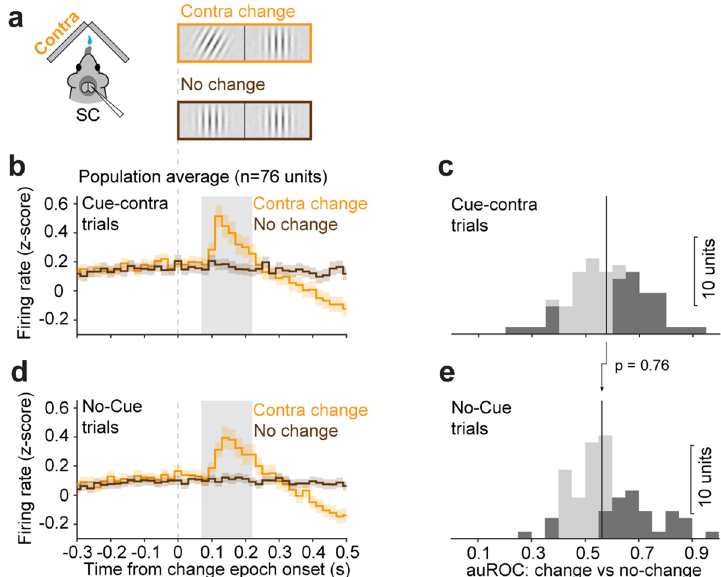
Figure 4. Spatial cueing did not alter the ability of SC neurons to detect contralateral changes. ( a ) Schematic of apparatus and events in “cue/no-cue” task. ( b ) Average normalized population PSTHs of SC neurons during “cue-contra” change trials (orange) and “cue-contra” no-change trials (brown). Traces are aligned on the change onset. Gray area: 150 ms change interval (60–210 ms after change onset) used to compute auROC comparing contralateral change and no-change trials. ( c ) Distribution of change vs no-change auROCs in contralaterally cued trials. Dark bars are units with auROCs significantly different from chance level. Dashed line indicates chance value of 0.5, solid line indicates population median (0.58). ( d ) Presentation as in ( b ) but in no-cue trials, comparing “no-cue contra” change (orange) to “no-cue” no-change (brown) trials. ( e ) Presentation as in ( c ), but in no-cue trials; (median = 0.56). The p value indicates comparison of population median between ( c ) and ( e ), paired-sample Wilcoxon signed-rank